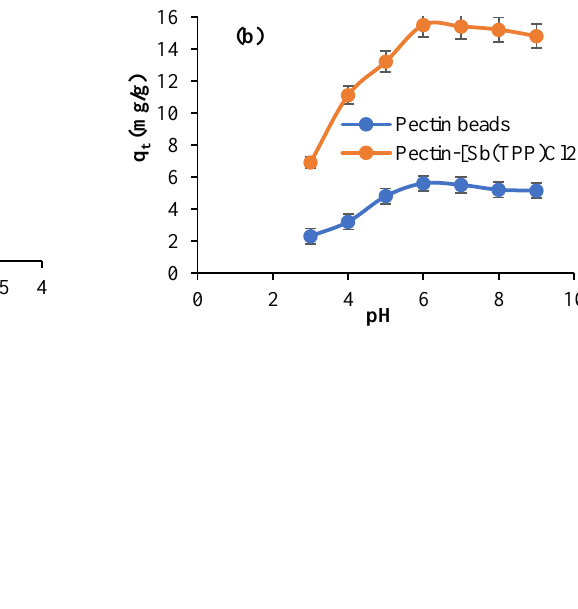
Figure 5. Thermal gravimetric analysis of: ( a ) pectin beads and ( b ) pectin − [Sb(TPP)Cl 2 ] composite beads (1%).